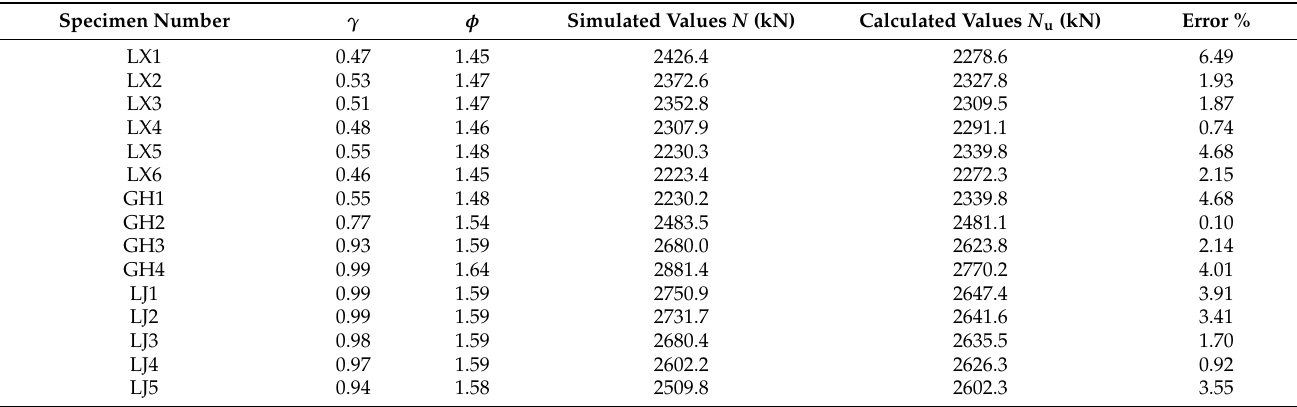
Table 6. Comparison of calculation